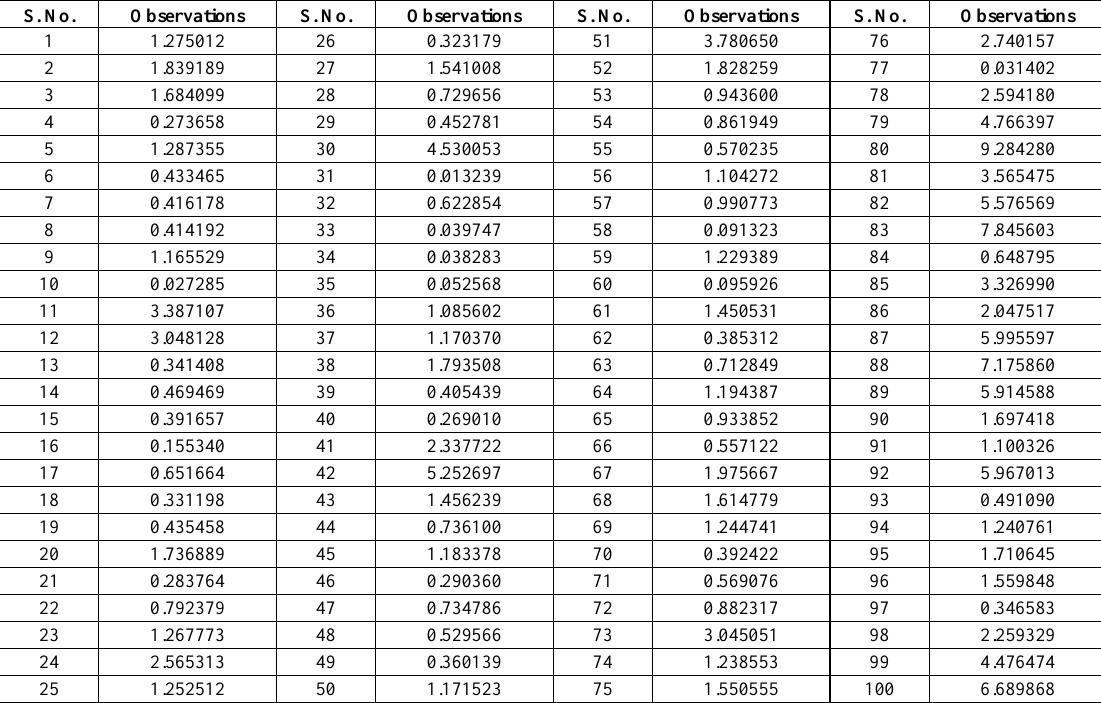
Table 1. Exponential distributed simulated observations in which the first 70 observations have mean of 1 and the remaining 30 observations have a mean of